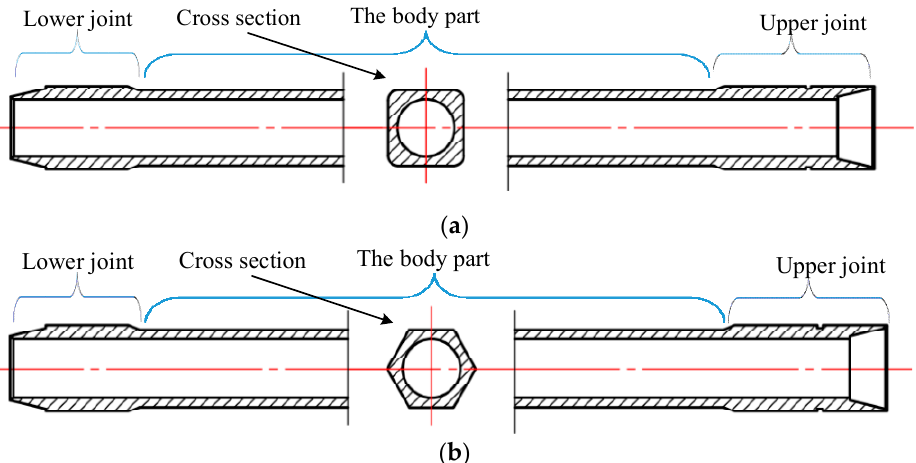
Figure 1. Structural diagram of polygonal drill pipes: ( a ) A square drill pipe; ( b ) a hexagonal drill pipe.